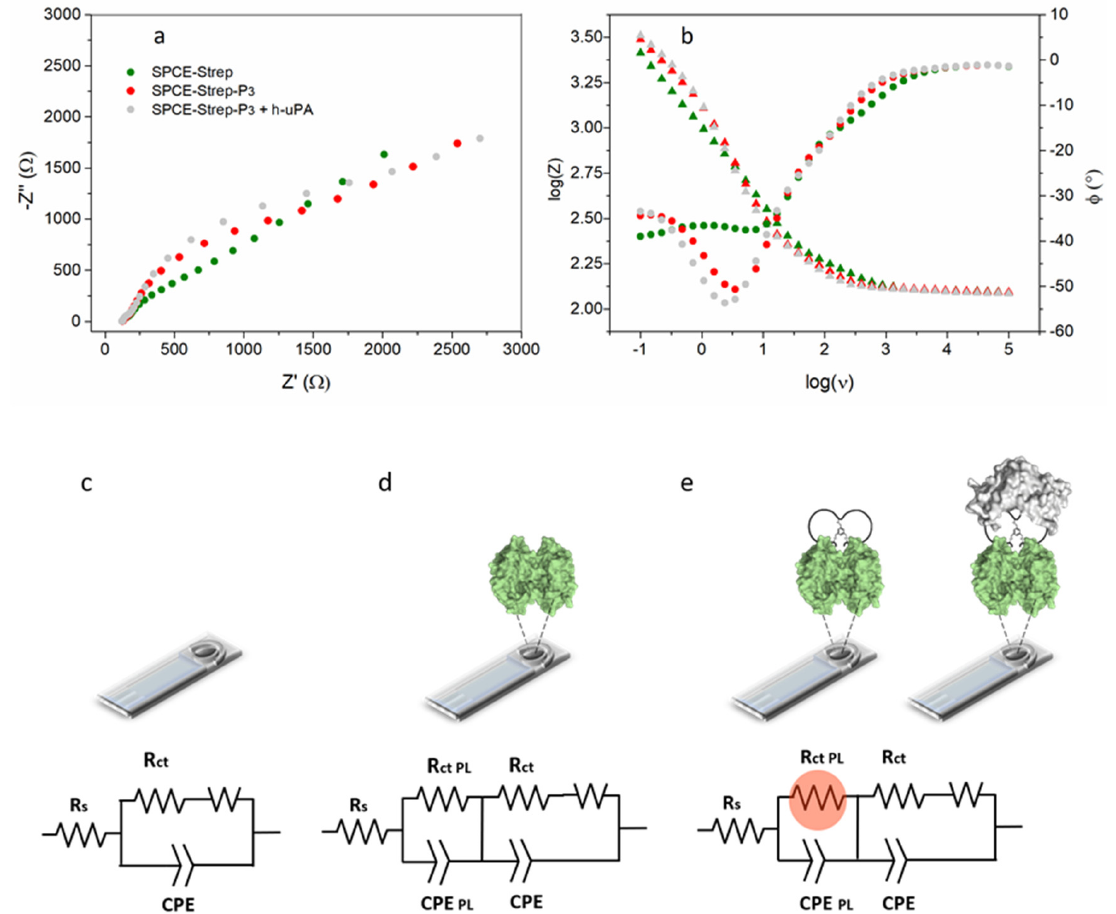
Figure 4. ( a ) Nyquist and ( b ) Bode plots for bare Strep-SPCE (green), P 3- modified Strep-SPCE (red) and P 3 -Strep-SPCE after incubation of 0.1 µgmL − 1 of h-uPA (grey). The data of the Bode phase plot are represented with circles, while the triangles correspond to the data of the Bode magnitude plot. All the measurement were performed in 1 mM solution of [Fe(CN) 6 ] 3 − /4 − . EECs describing the Nyquist plots reported in ( a ) and the response of an unmodified SPCE: ( c ) the processes occurring at a bare SPCE/solution interface can be modelled with a standard Randles circuit, ( d , e ) modified EEC describing the presence of a poorly conductive layer (protein layer, PL).